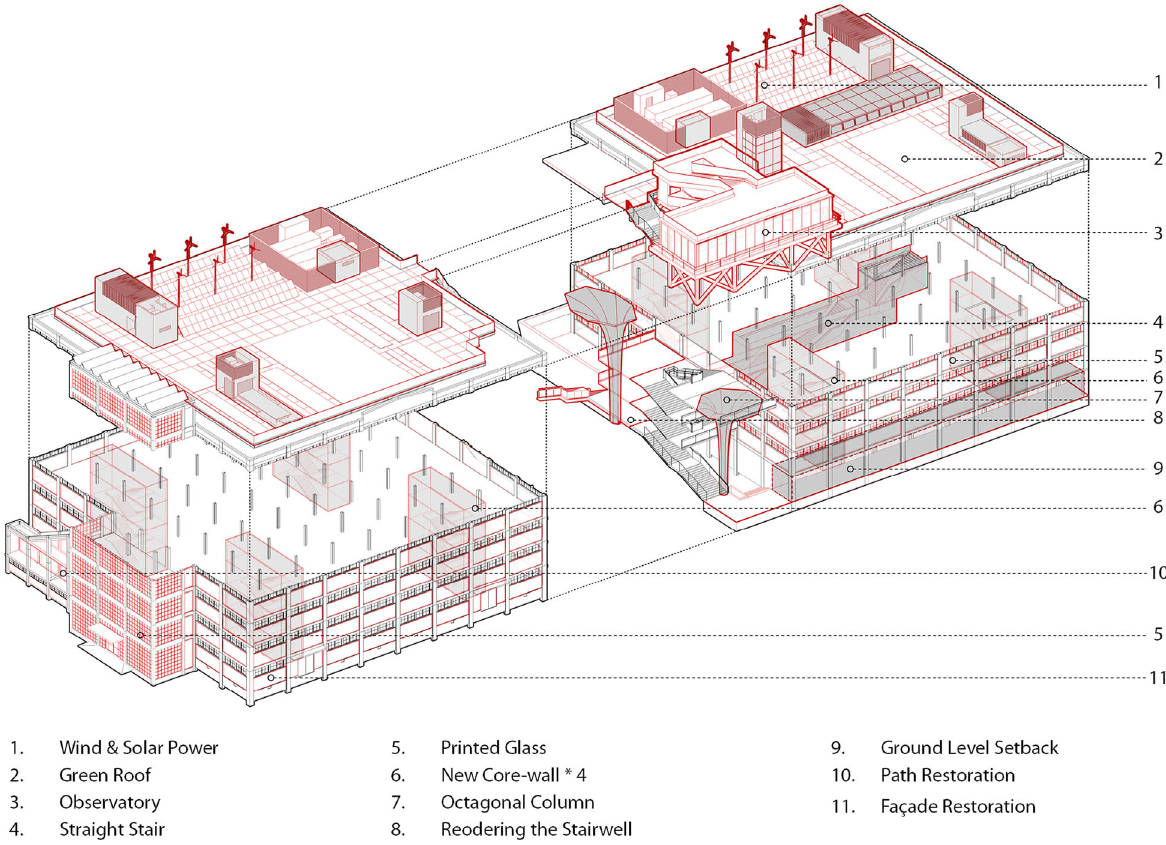
Fig. 10 Axonometric view of Yong ’ an Warehouse (Source: Archi-Union